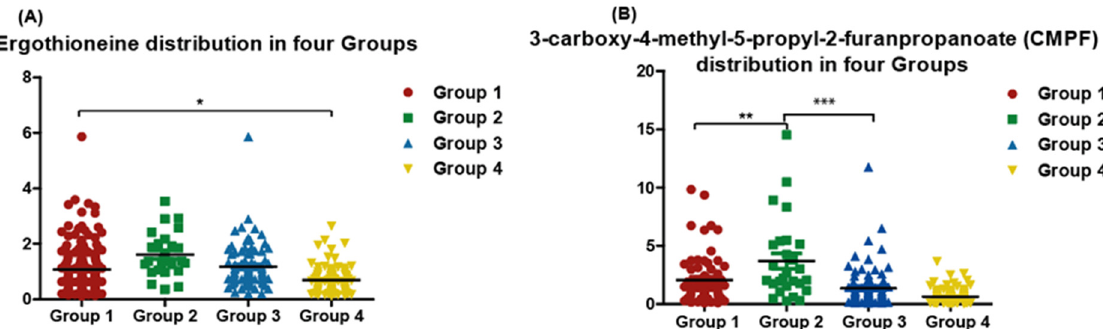
Figure 5. Quantitative distribution of Ergothioneine ( A ) and 3 ‐ carboxy ‐ 4 ‐ methyl ‐ 5 ‐ propyl ‐ 2 ‐ fu ‐ ranpropanoate (CMPF) ( B ) among four groups. Vitamin D sufficient and normolipidemic (Group 1, n = 64); vitamin D sufficient and dyslipidemia (Group 2, n = 26); vitamin D deficient and dyslipidemia (Group 3, n = 88); vitamin D deficient and normolipidemic (Group 4, n = 99). Y axis is log transformed abundance levels of metabolites. * Significant p value comparing Ergothioneine levels in Group 1 (Vitamin D sufficient) to Group 4 (Vitamin D deficient). ** Significant p value comparing CMPF levels in Group 1 (normolipidemic) to Group 2 (dyslipidemic). *** Significant p value comparing CMPF levels in Group 2 (Vitamin D sufficient) to Group 3 Vitamin D deficient in dyslipidemic